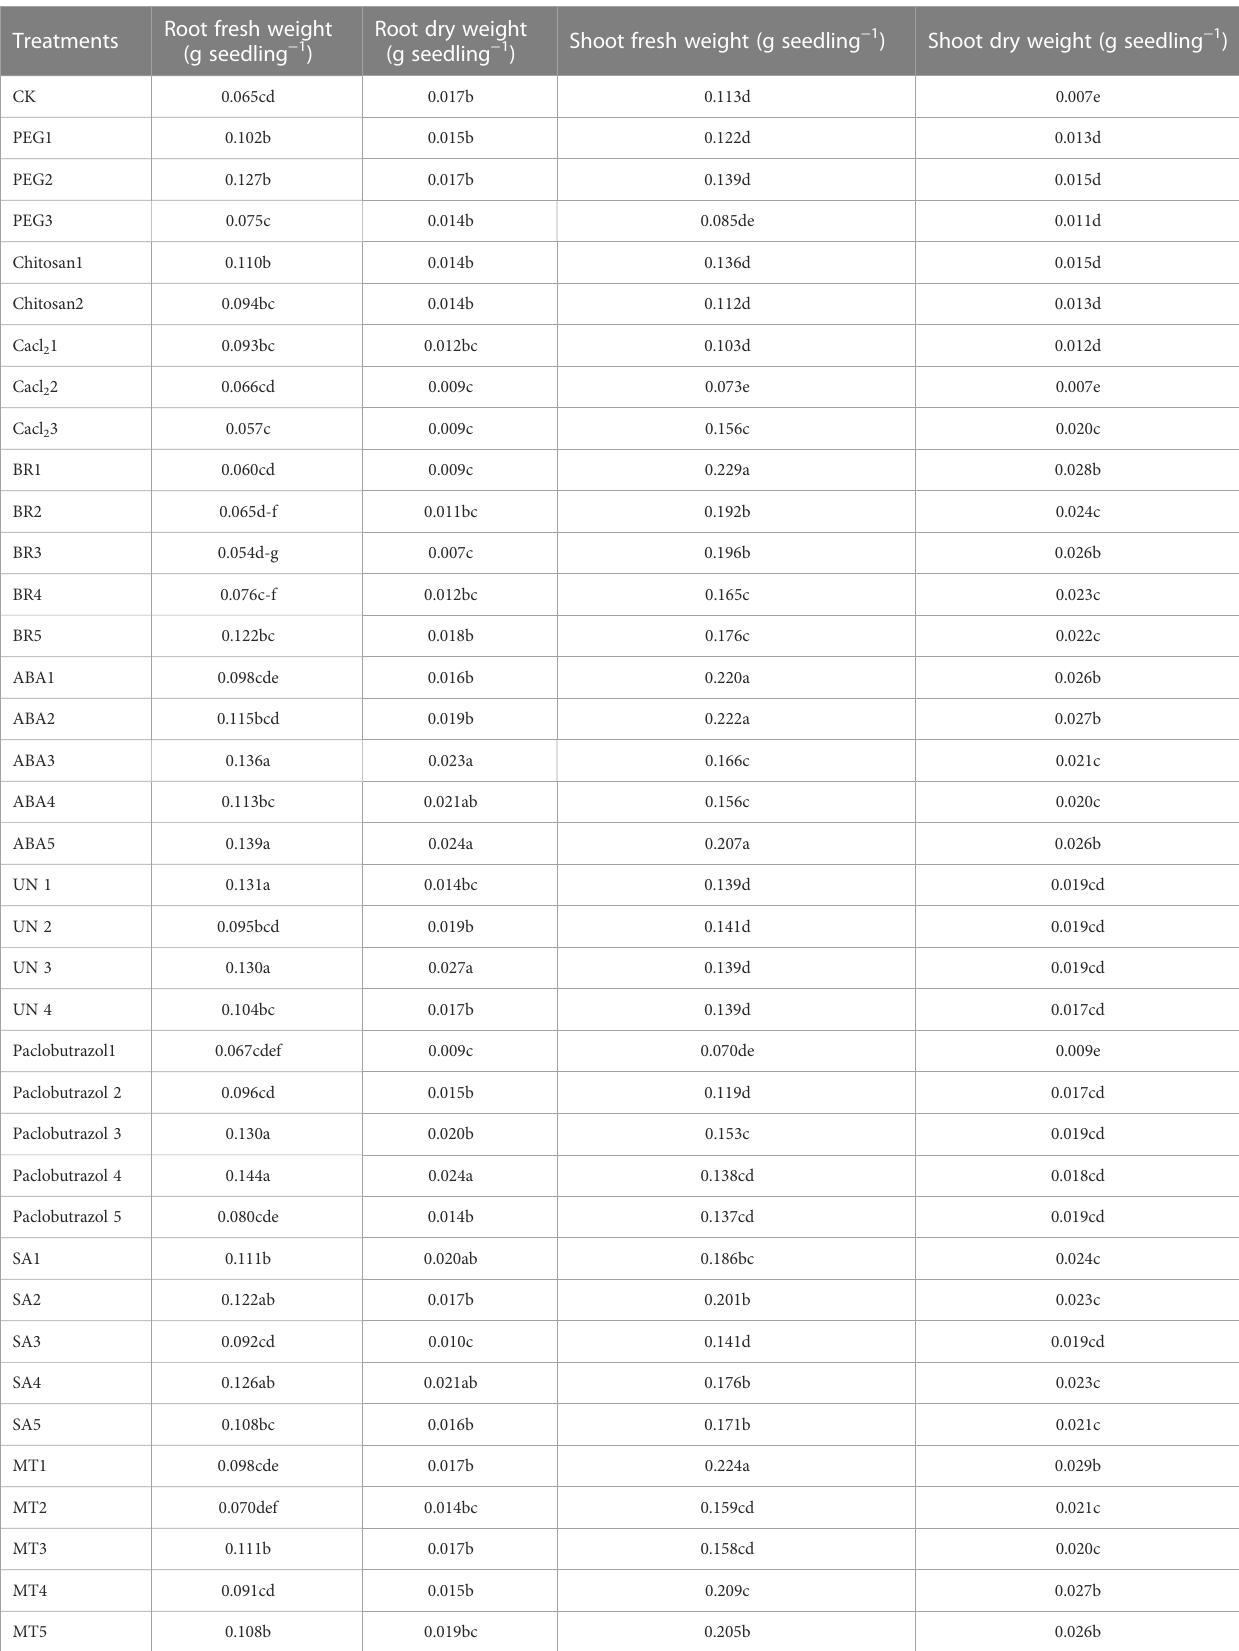
TABLE 1 Responses of the fresh and dry weights of the roots and shoots to various seed priming treatments under different chilling stressors.